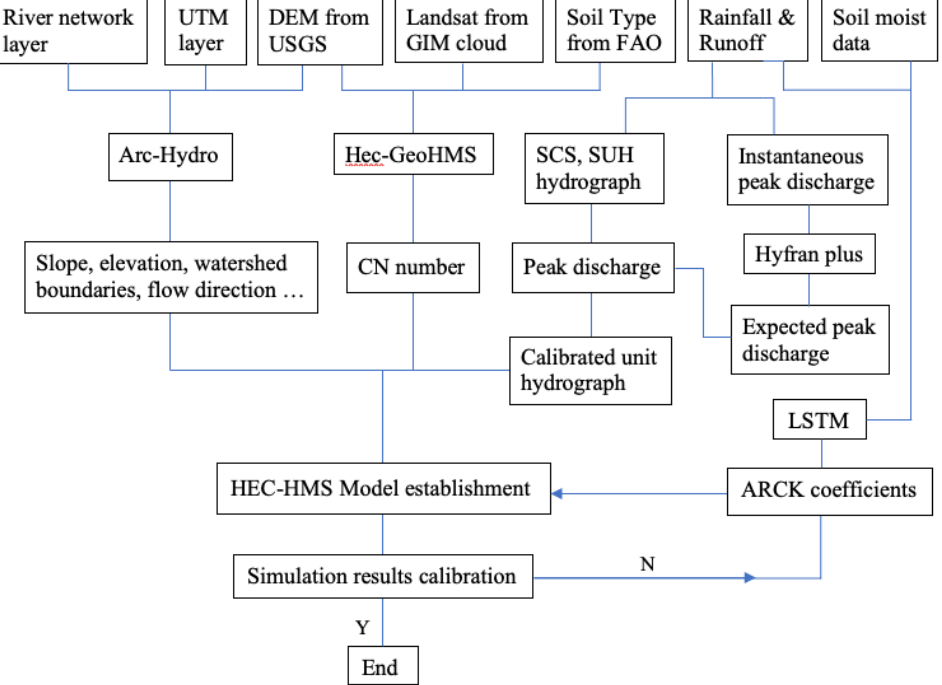
Figure 3. Flowchart of the methods and extensions used in different stages to build the model.